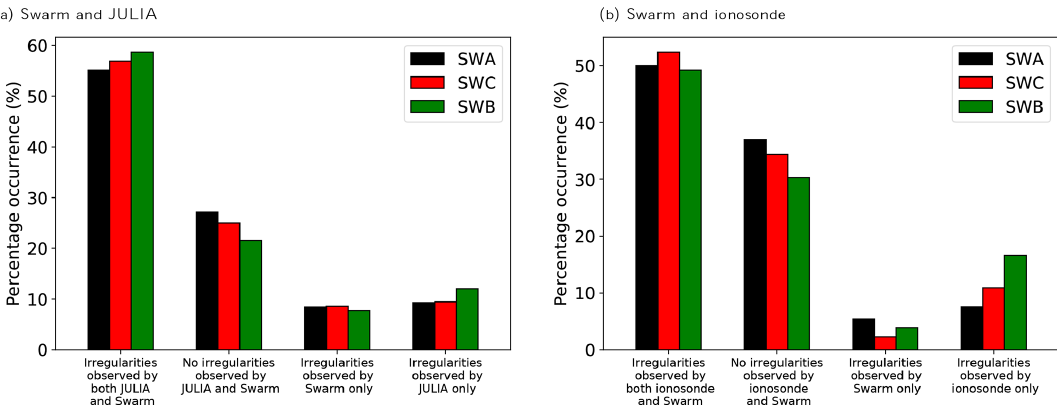
Figure 7. Percentage occurrence of irregularities in each category observed by (a) the Swarm satellites and JULIA observations and (b) the Swarm satellites and ionosonde observations for the years from 2014 to